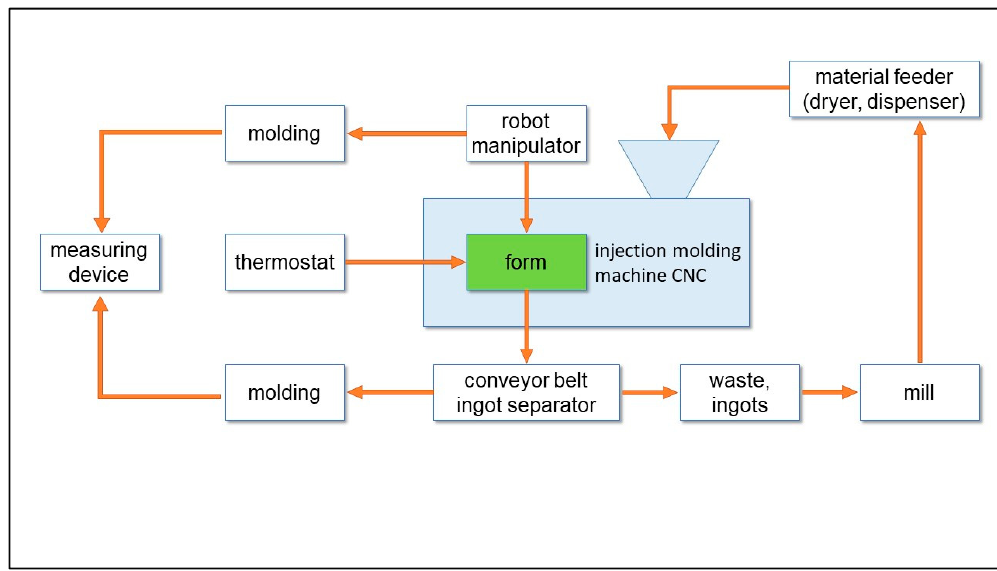
Figure 6. Automated production cell of injection moulding machine.